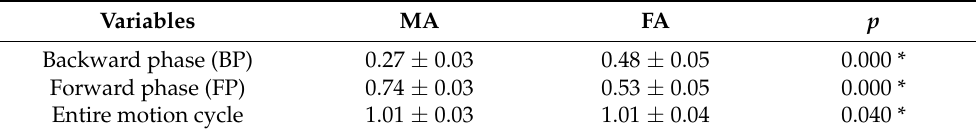
Table 2. Comparison of means ± standard deviations for BP and FP times between MA and FA (unit: seconds).